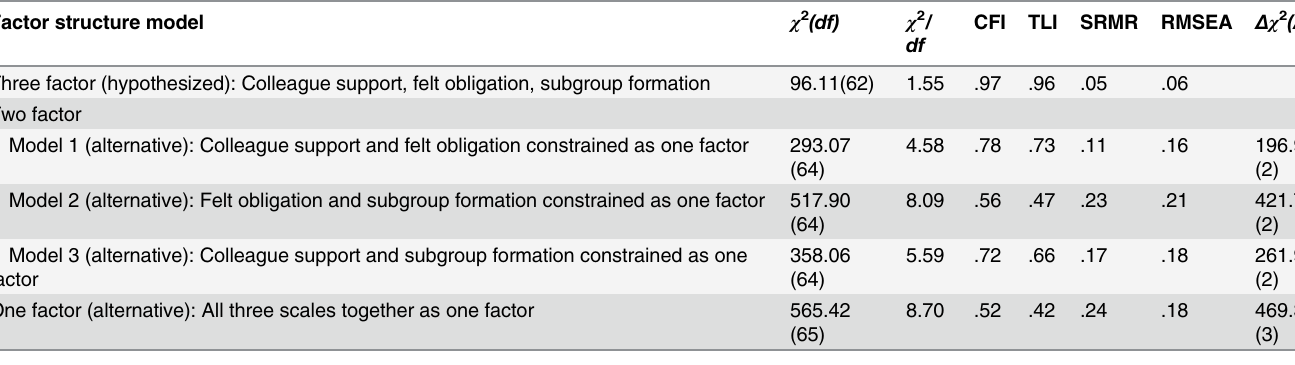
Table 1. Confirmatory factor analysis of key variables in the